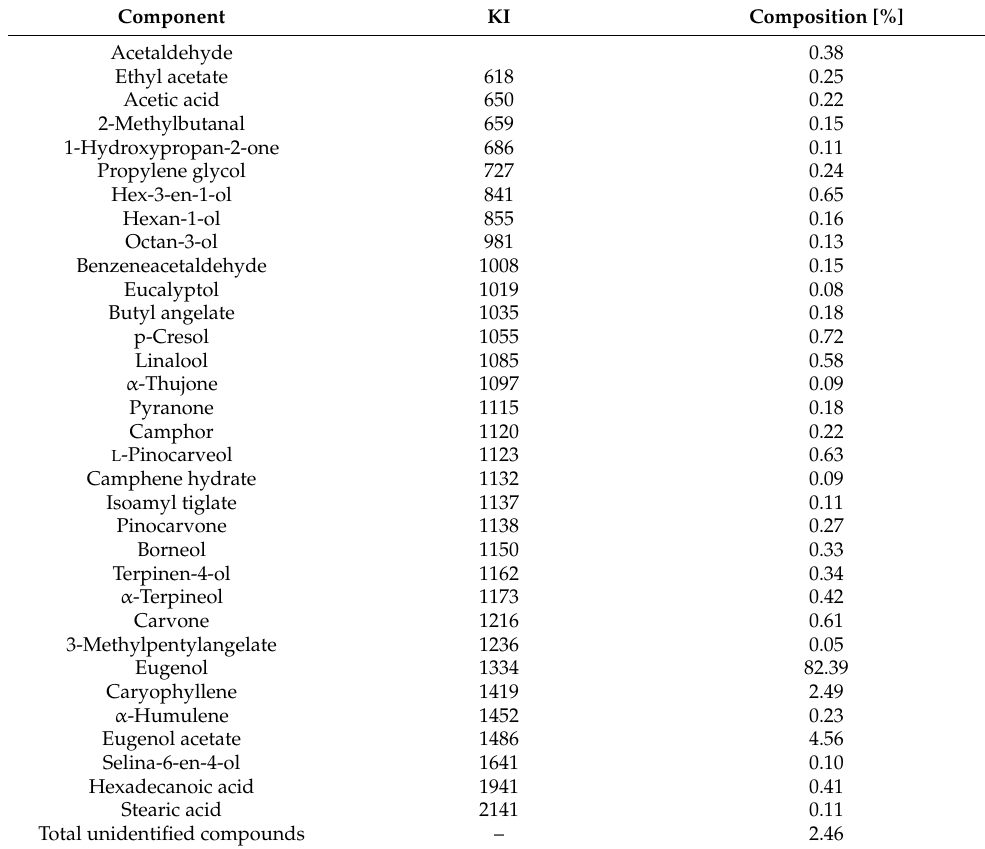
Table 3. Volatile compounds of Caryophyllus aromaticus L. water